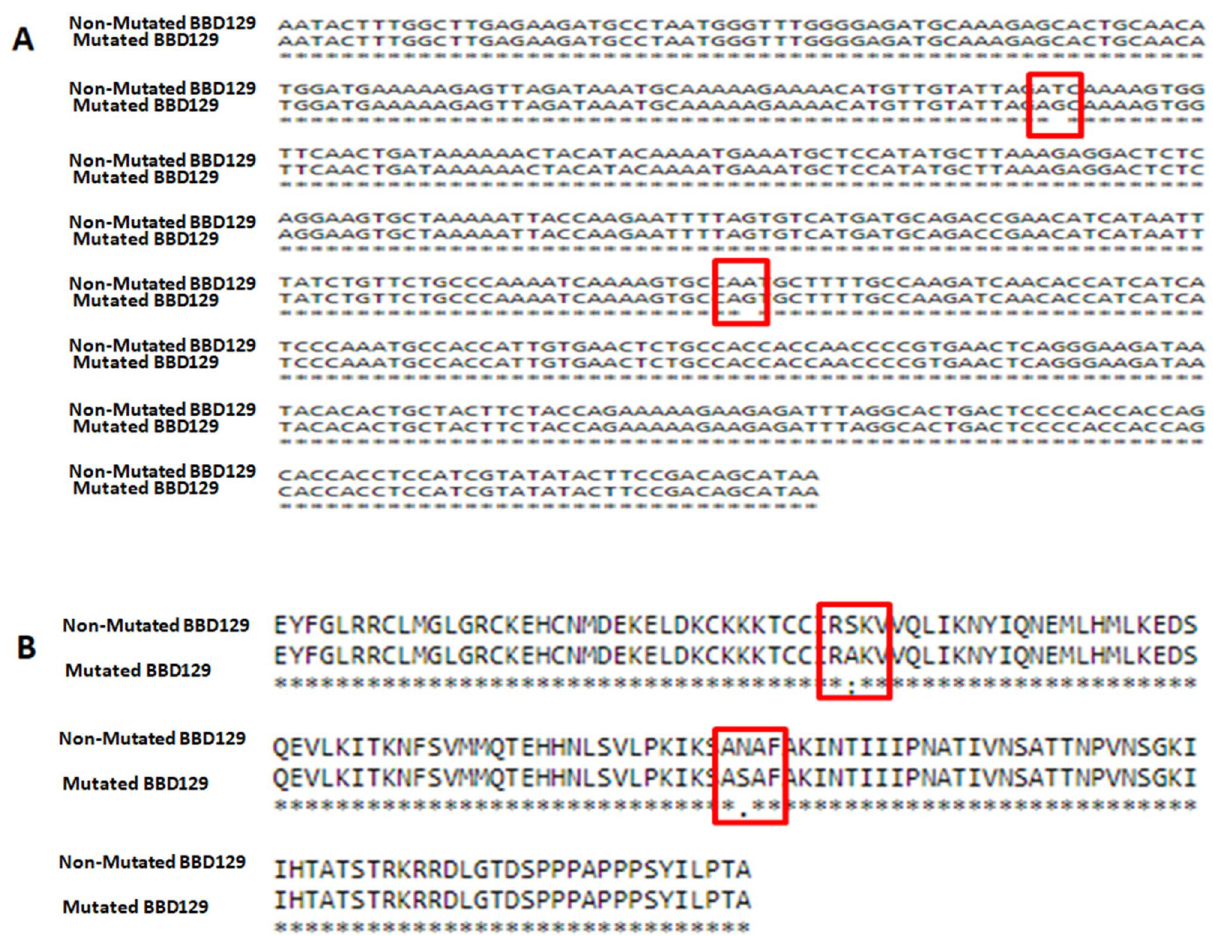
Figure 4. NCBI-BLAST of genomic DNA amplified BBD129 gene from distinct fertility cross-bred cattle bulls. ( A ) The sequence variations were observed at the nucleotide level in the in the sequenced clones. Two polymorphisms were found in the exon-2 at 169th (T/G) and 329th (A/G) nucleotide positions. ( B ) The variations were also observed at the amino acids level. The BBD129 gene has shown two amino